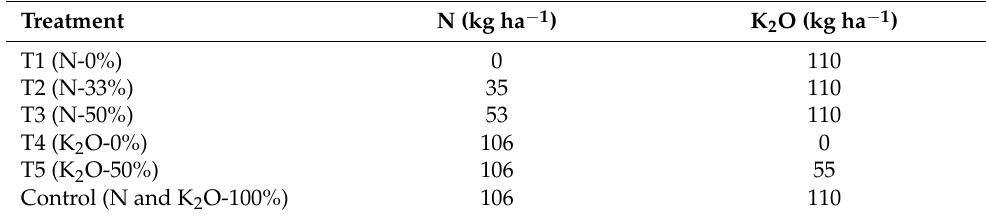
Table 1. Doses of nitrogen and potassium (kg/ha) applied in each treatment of the persimmon tree nutrient